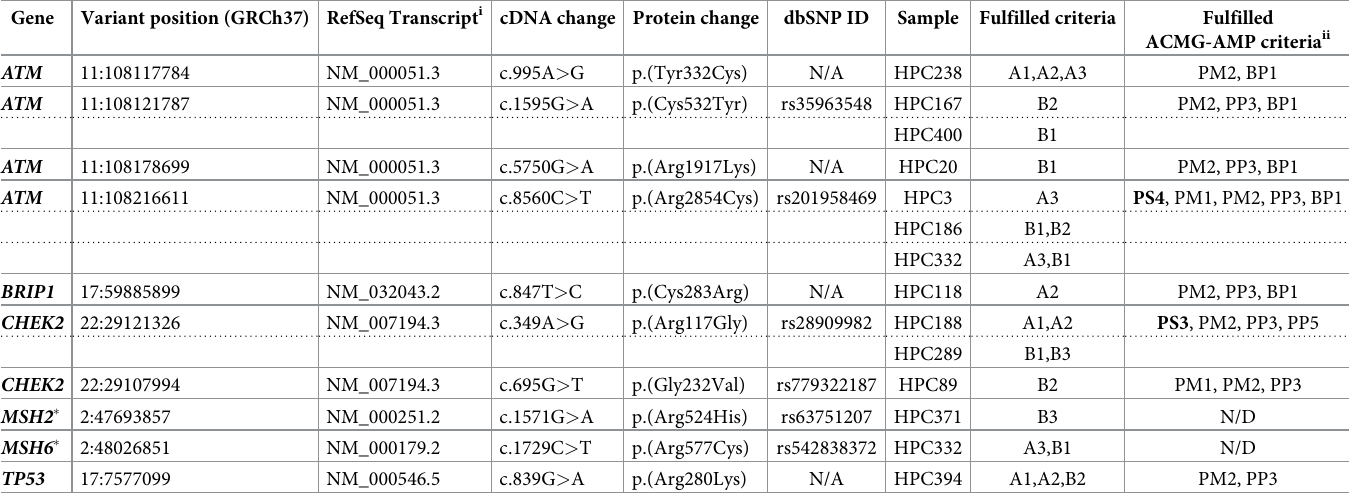
Table 2. “Likely/Potentially pathogenic” missense variants found in the 121 cases by targeted NGS panel. Gene Variant position (GRCh37) RefSeq Transcript i cDNA change Protein change dbSNP